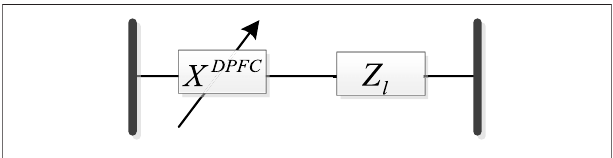
FIGURE 5 | Reactance model of the